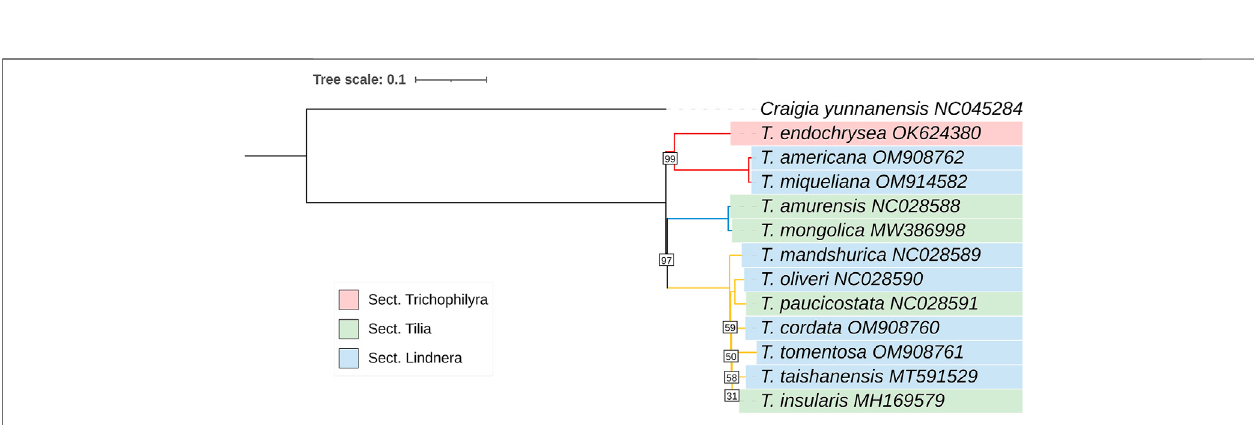
FIGURE 6 | Maximum-likelihood treeof 12 Tilia species based on all variation sites. The numbers associated with the nodes are bootstrap support and posterior probability values. All the nodes with bootstrapping equal to 100 was not mentioned. 1000 bootstrap replicates.